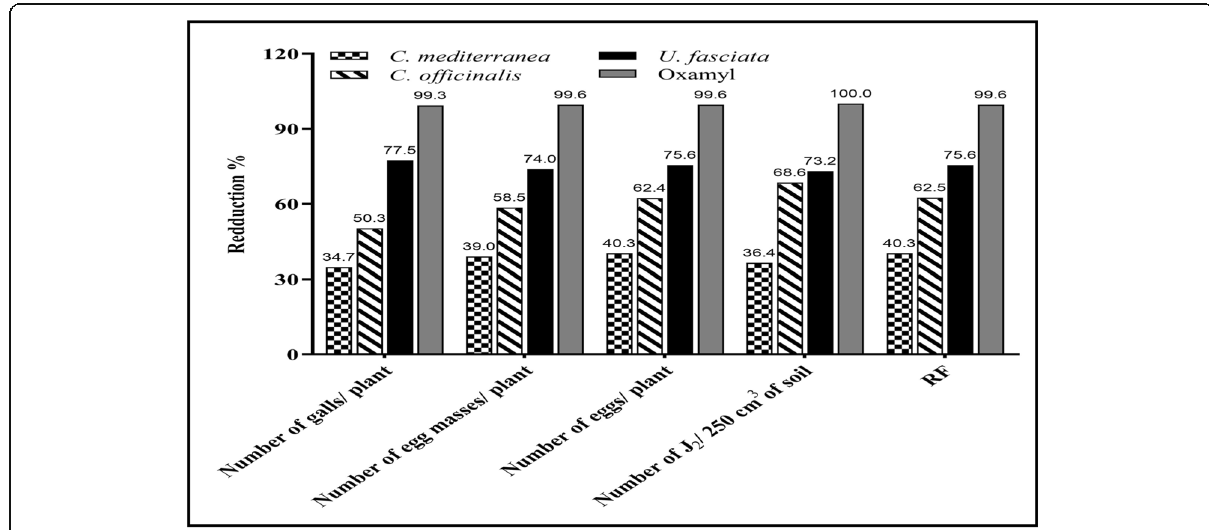
Fig. 1 Reduction percentage of nematode galls, egg masses, eggs/plant root, second stage J 2 population in soil and reproduction factor ( RF. ) of tomato plants inoculated with M . incognita and treated with C . mediterranea , C . officinalis , U . fasciata extracts and the nematicide, oxamyl under greenhouse conditions